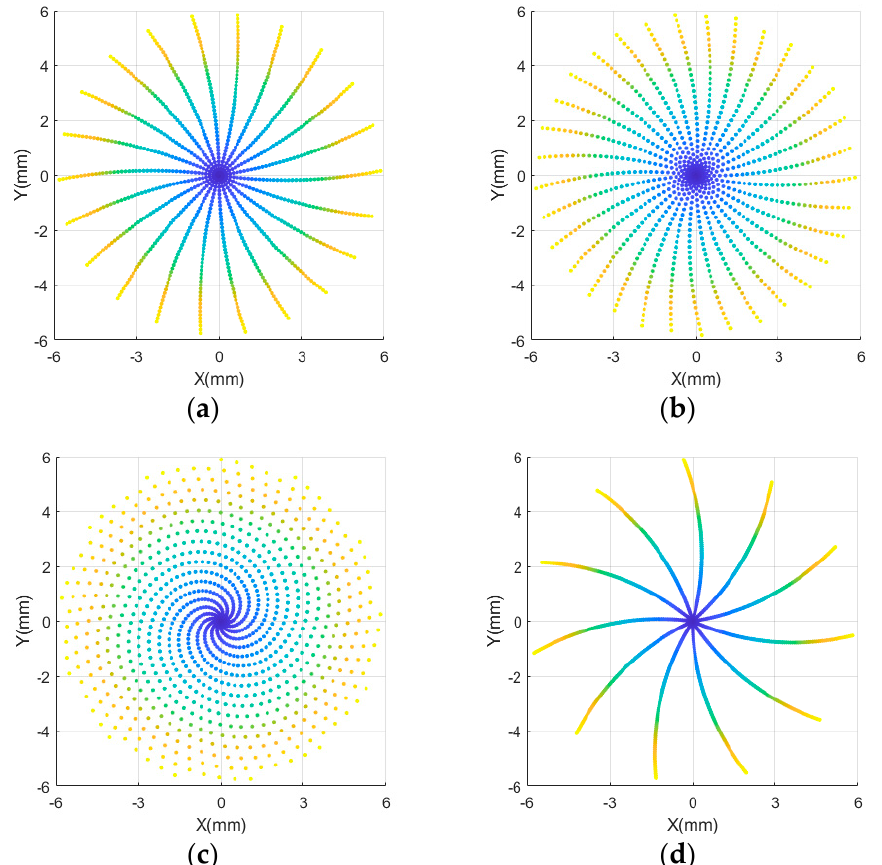
Figure 6. Tracking of abrasive particles in the grinding center under different workpiece matching speeds. ( a ) r30, ( b ) r40, ( c ) r50, ( d ) r60.